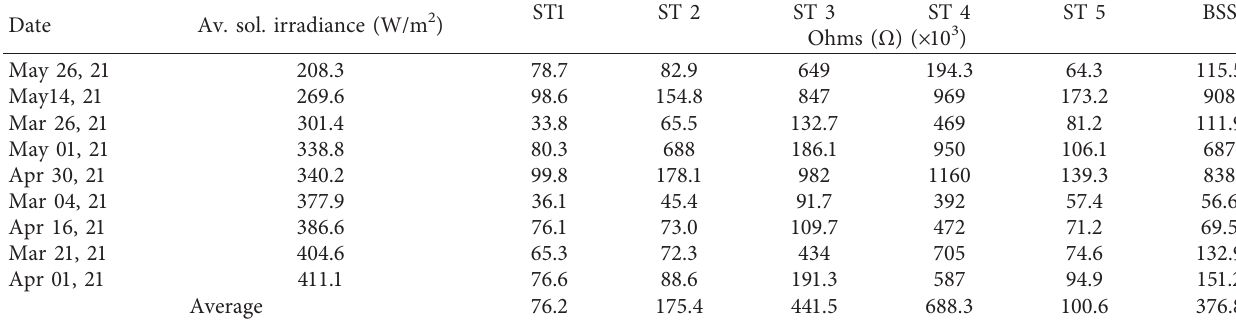
Table 1: Distillate electrical resistance results per stage of the MSS-SS.